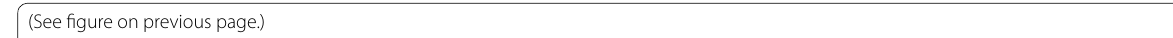
Table 1 Patients’ main characteristics Patient # Age (years) Sex Body mass index (Kg/m 2